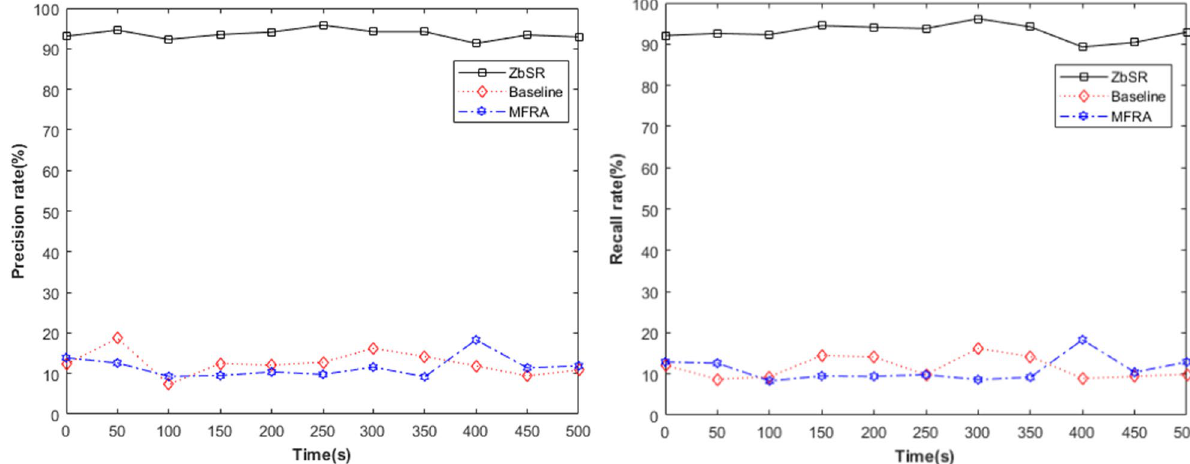
Figure 13. Precision rate and recall rate of malicious flow in 3